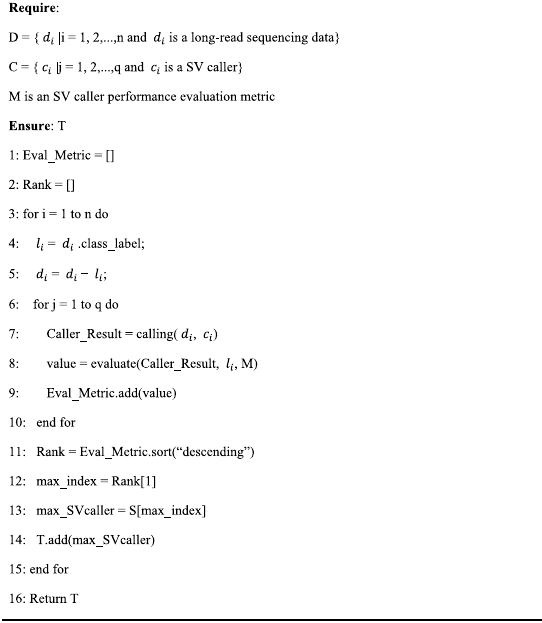
Algorithm 2. Meta-target identi fi